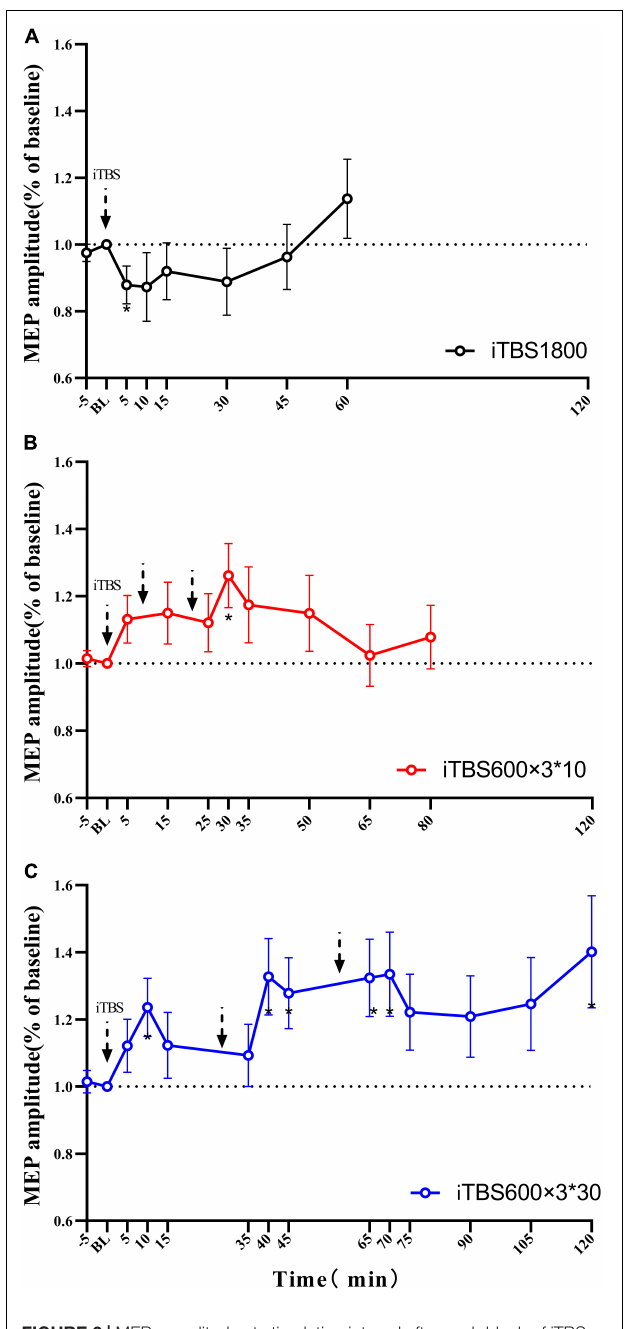
FIGURE 2 | MEPs amplitude at stimulation interval after each block of iTBS and up to 60 min post 1800 pulses of iTBS in difference iTBS conditions. For each cluster of (A) iTBS1800 (B) iTBS600 × 3 ∗ 10 (C) iTBS600 × 3 ∗ 30. Asterisks indicate statistical significance between the MEPs amplitude at that time point and the baseline MEPs amplitude (* P <